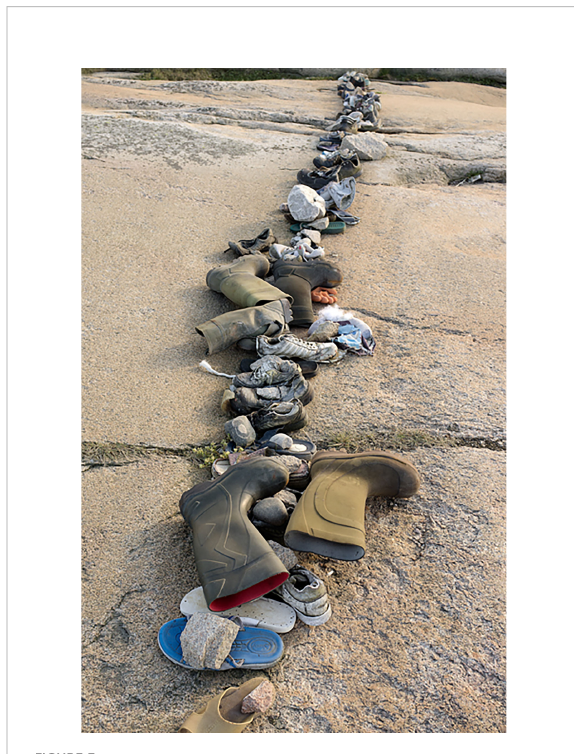
FIGURE 3 Many different human activities damage the seas. What do our human footprints or impacts look like? Looking at the photo through the lens of art, one imagines that the question also addresses multiple human stresses on the seas? (Photo courtesy of Hillevi